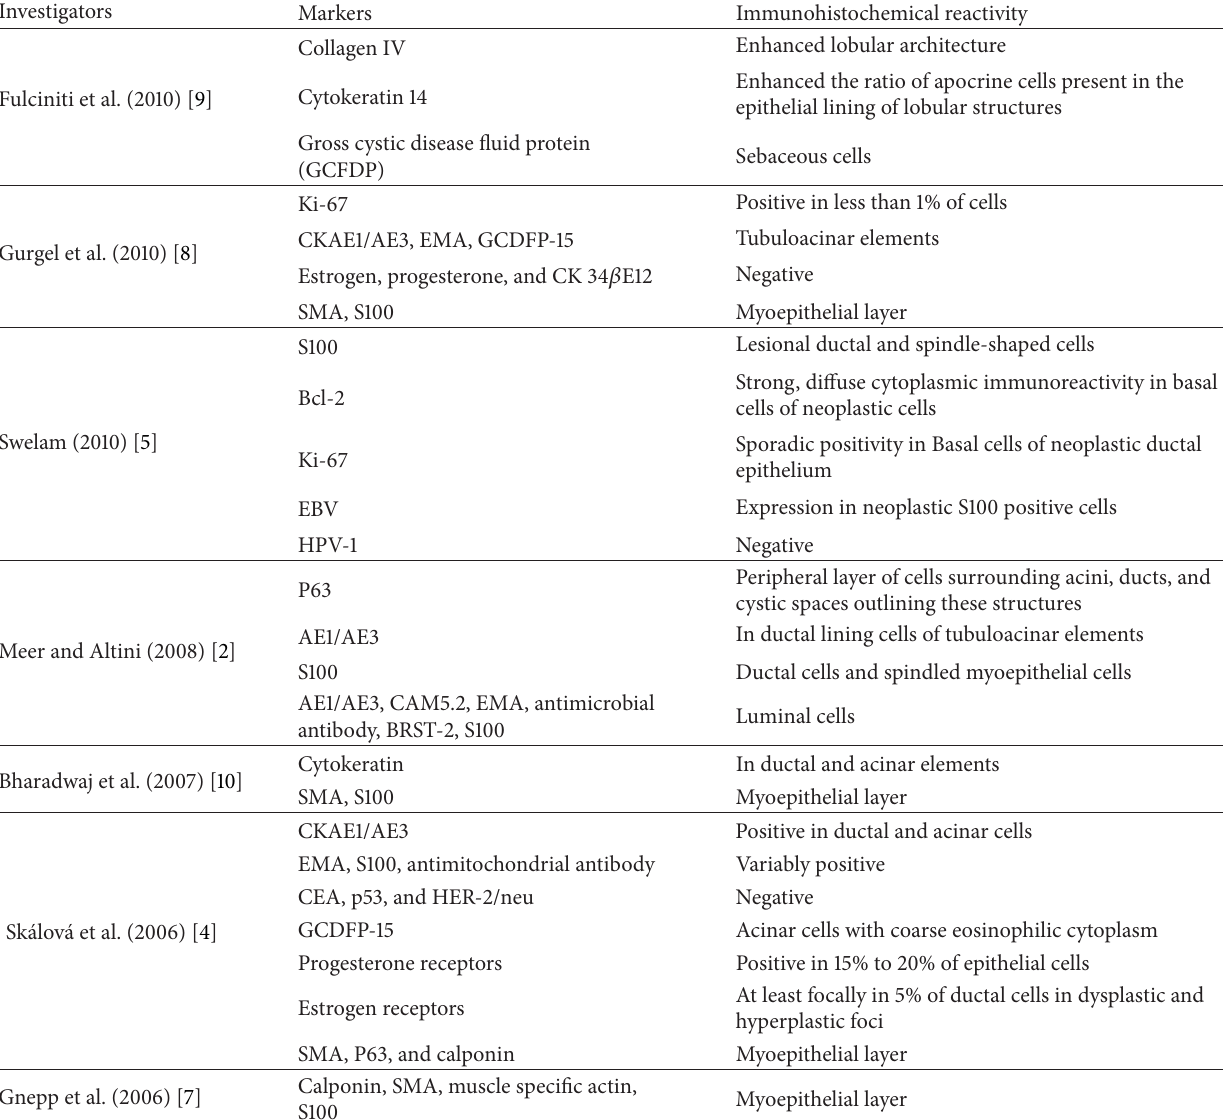
Table 1: A review of immunohistochemical investigations in SPA